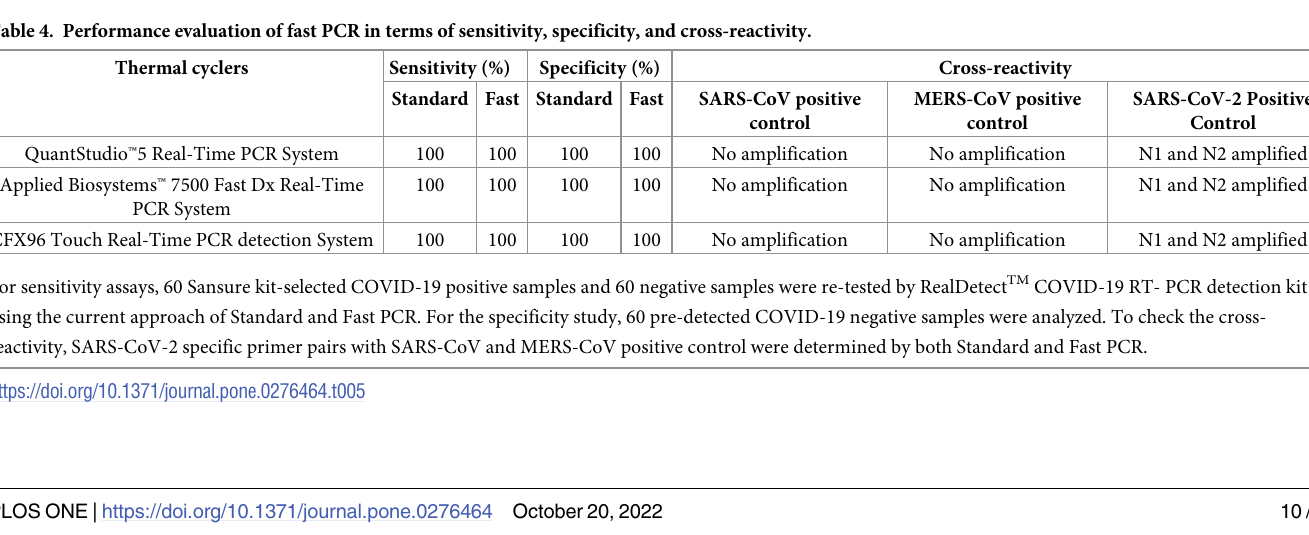
To investigate PCR amplification efficiency, linear regression analysis was performed using Ct values generated due to PCR amplification of 10-fold serially diluted solutions containing N1, N2 and RP positive controls having 10000, 1000, 100, 10 and 01 copies each. Finally, R 2 values were obtained.